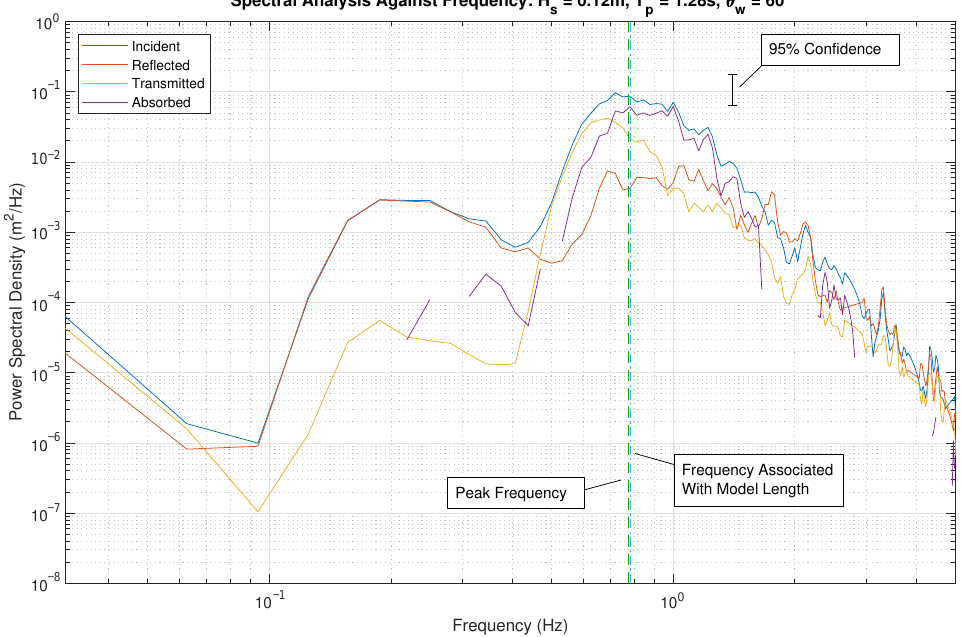
Figure 7. Spectral analysis of H s = 0.12 m, T p = 1.28 s, θ w = 60 ◦ . Incident, reflected, transmitted and absorbed spectra are shown in blue, orange, yellow and purple,